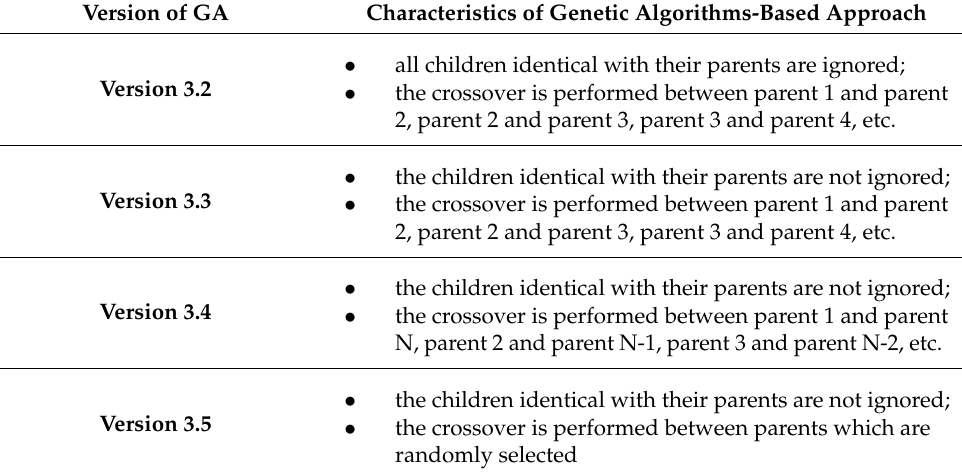
Table 5. The characteristics of the genetic algorithm-based approaches developed during the present work related to the smart lamp controller